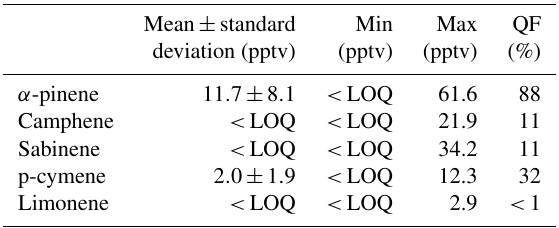
Table 2. Average mixing ratios with standard deviation, along with minimum (min) and maximum (max) values and the quantification frequency (QF) of the measured monoterpenes in ambient air. LOQ stands for limit of quantification. For values lower than the LOQ, mixing ratios equal to half of the LOQ were used to calculate the mean. Mean ±